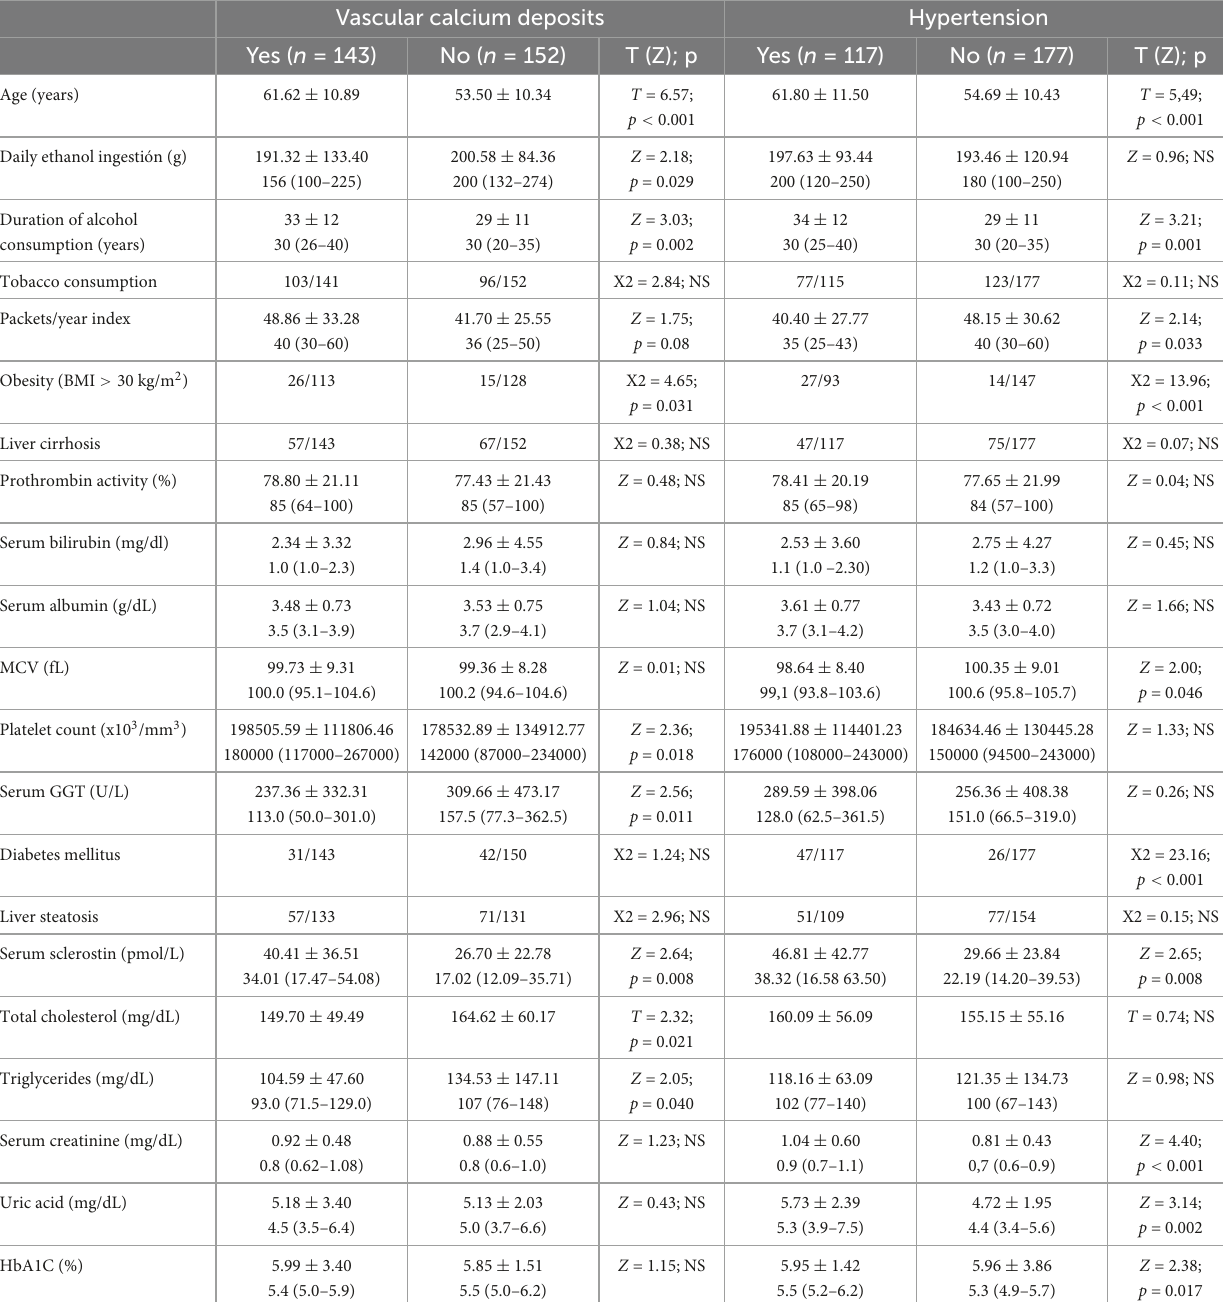
TABLE 1 Some biological features in patients with or without vascular calcium deposits and with or without